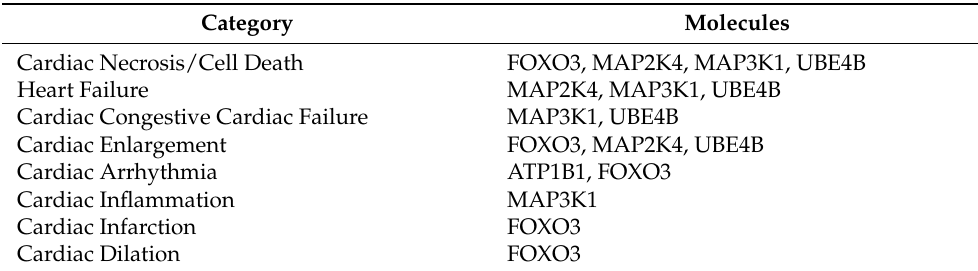
Table 7. Cardiotoxicity functions of hsa-miR-21-3p targets. Cardiotoxicity functions identified